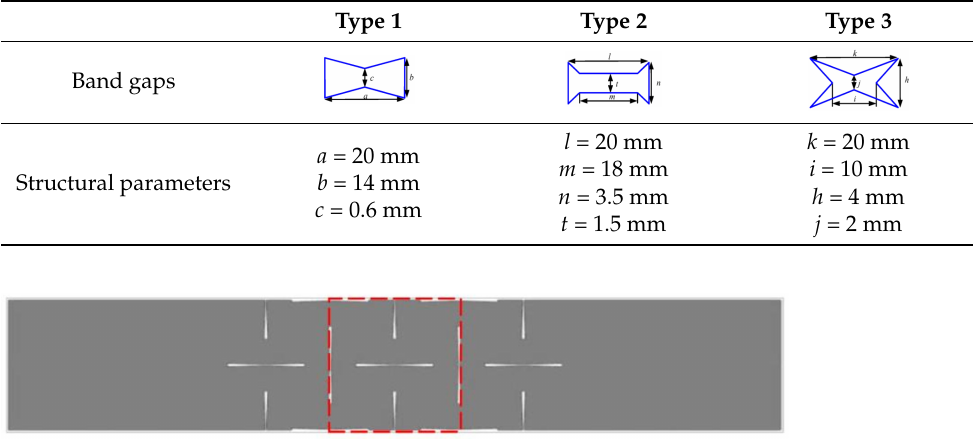
Table 1. Band gap types and parameters.